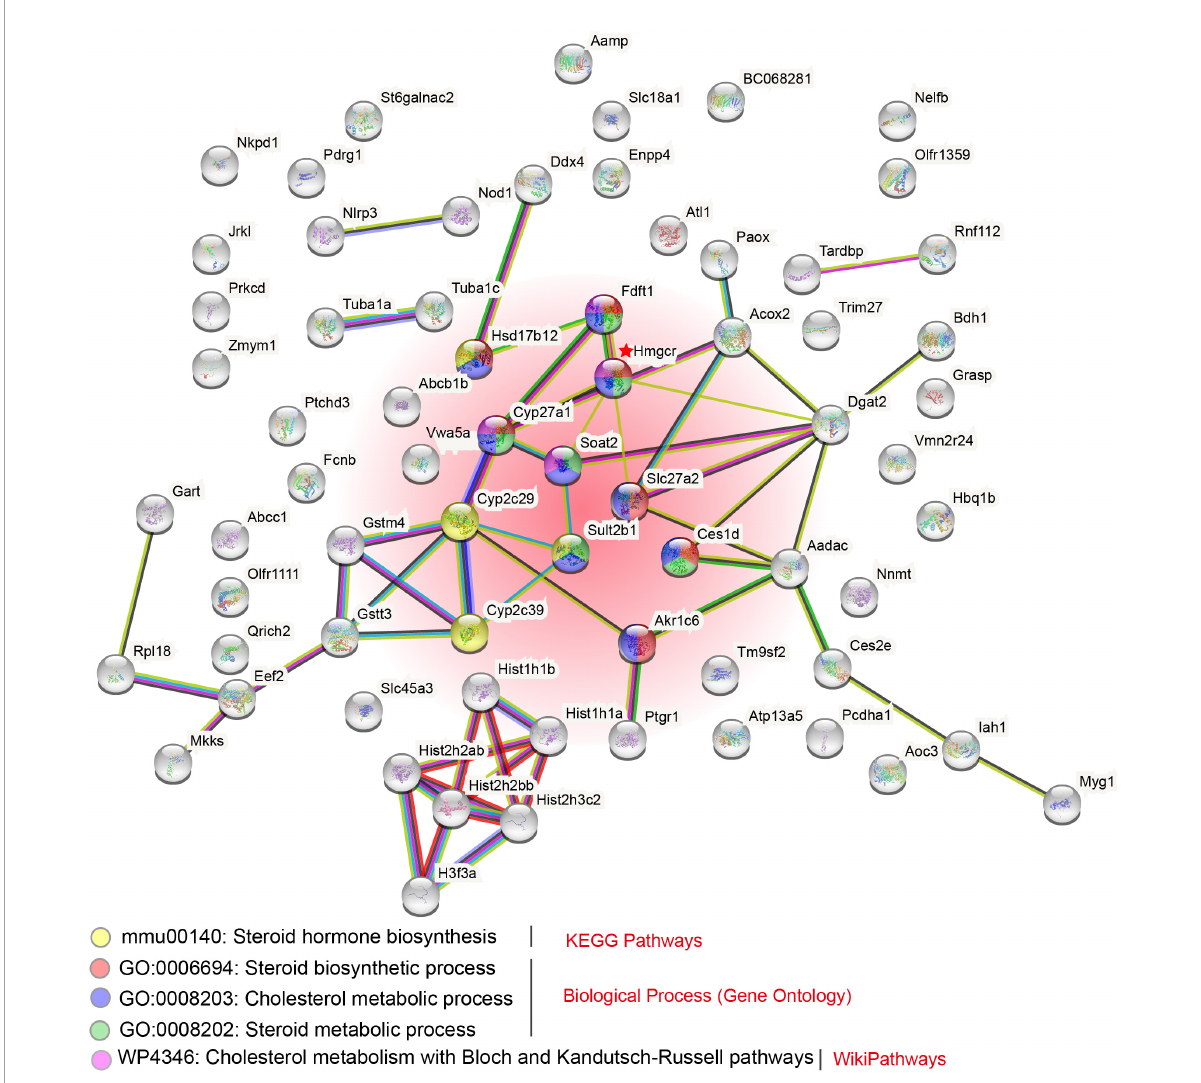
FIGURE5 Proposed protein–protein interaction (PPI) network of the proteins encoded by overlapped genes. Several enriched pathways, related to steroid or cholesterol biosynthesis from KEGG, GO, and Wiki databases, were highlighted. The red shaded region includes those pathways at the figure